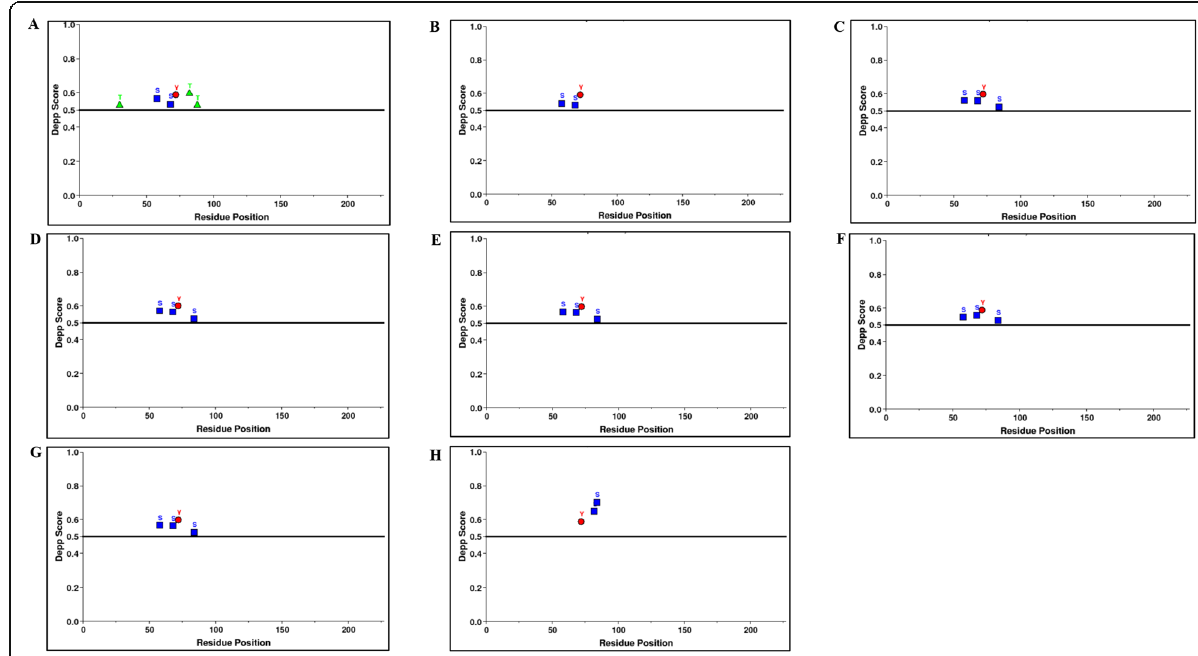
Fig. 8 Prediction of phosphorylation sites showing the scores of phosphorylated residues (Ser, Thr, Tyr) along with the depicted scores within YDR. A JF443720 (GT 1); B M74506 (GT 2); C AB222182 (GT 3); D GU119961 (GT 4); E AB573435 (GT 5); F AB602441 (GT 6); KJ496143 (GT 7); and H KX387865 (GT 8). Graphs A – H represent the phosphorylation patterns of the YDR sequences of HEV. The score was computed using DEPP (Disorder Enhanced Phosphorylation Predictor). A threshold value of 0.5 was set to distinguish between ordered and disordered regions along the genome (line). The predicted phosphorylated residues above the threshold are represented as Ser (S), blue; Thr (T), green; and Tyr (Y), red